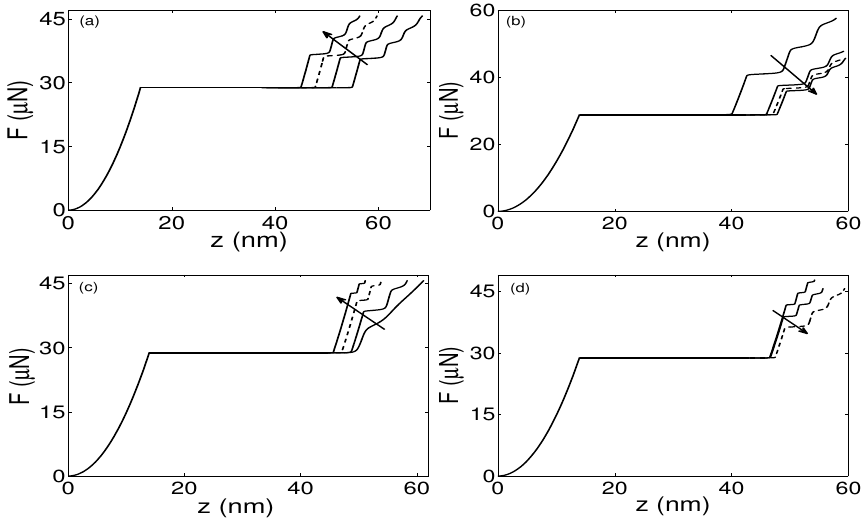
Figure 6. Variation of one parameter keeping other parameters fixed as in Table 3. The direction of the arrow in each of these plots represents increasing values of the parameters. ( a ) plots of load as a function of z for σ m / E ∗ = 1/105,1/92,1/82 and 1/74; ( b ) plots of F − z curves for velocity exponent m = 4,8,10,12; ( c ) plots of F − z curves for four values of δ = ( 0.06,0.158,0.32,3.16 ) × 10 − 6 m/s keeping f = 0.01; ( d ) plots of F − z curves for f = 0.01,5,10 for δ = 1.58 × 10 − 6 m/s, after